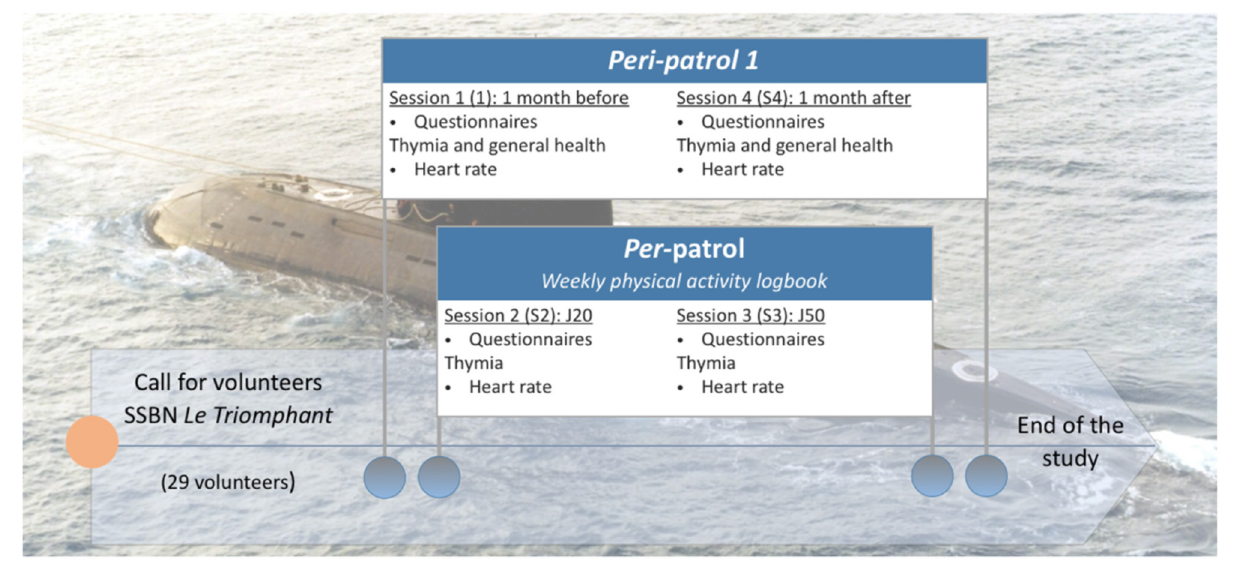
For the pre-departure collection, the percentages